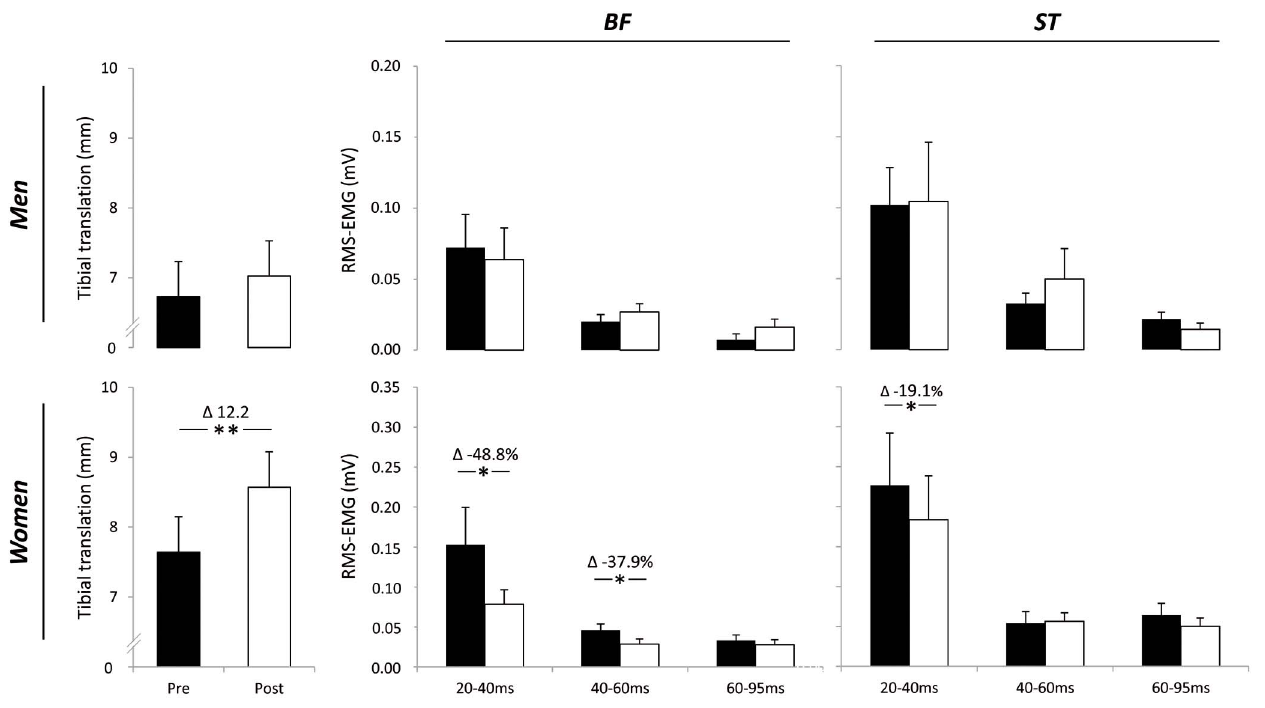
Figure 3. Effect of fatigue on tibial translation (left) and reflex responses (middle and right). Filled bars: Pre, open bars: Post, BF: biceps femoris, ST: semitendinosus/semimembranosus. Data are displayed as means 6 standard error of the mean. * denotes a significant difference compared to the pre-measurement, * P # 0.05; ** P # 0.01.